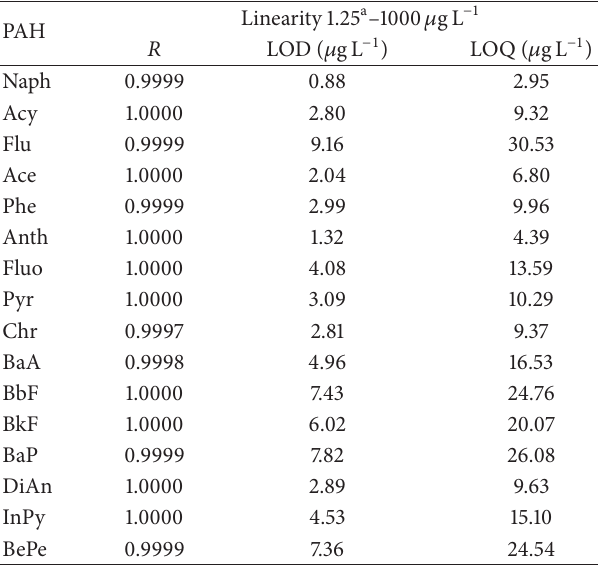
Table 4: Linearity, limits of detection (LOD), and quantification (LOQ) of the analytical method with the Kinetex column at 16 ∘